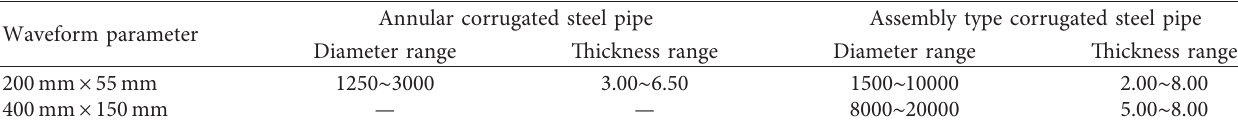
Figure 7: Time history curve of experiment and simulation: (a) the lateral displacement of the top of the column, (b) the lateral velocity of the top of the column, and (c) the lateral acceleration of the top of the column. Table 2: Common specifications [43] (unit: